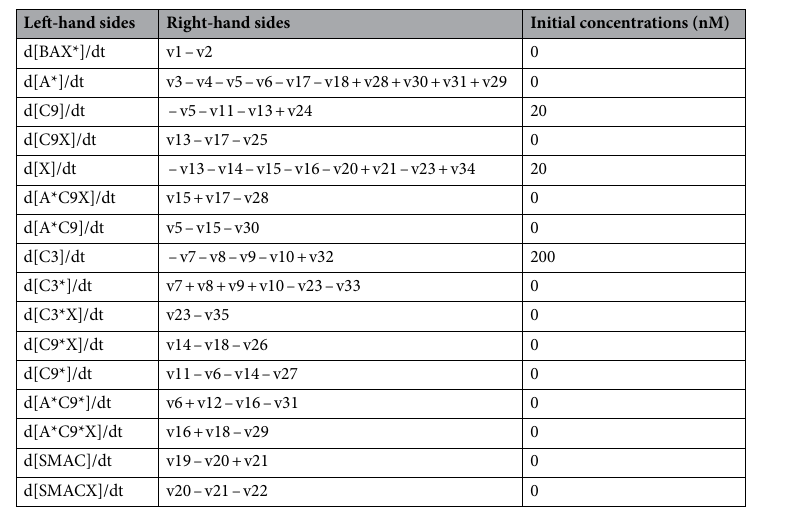
Table 2. Table of ordinary differential